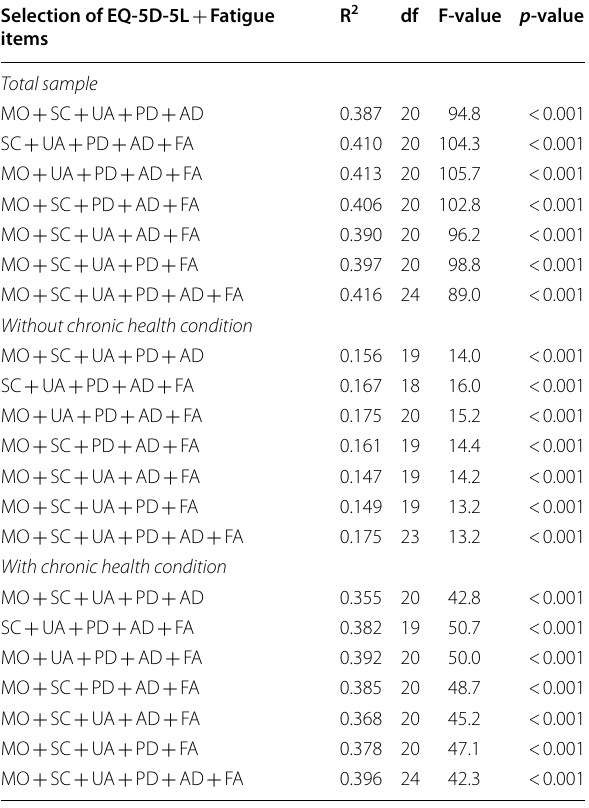
MO, mobility; SC, self-care; UA, Usual activities; PD, Pain/discomfort; AD, Anxiety/ depression; FA, Fatigue